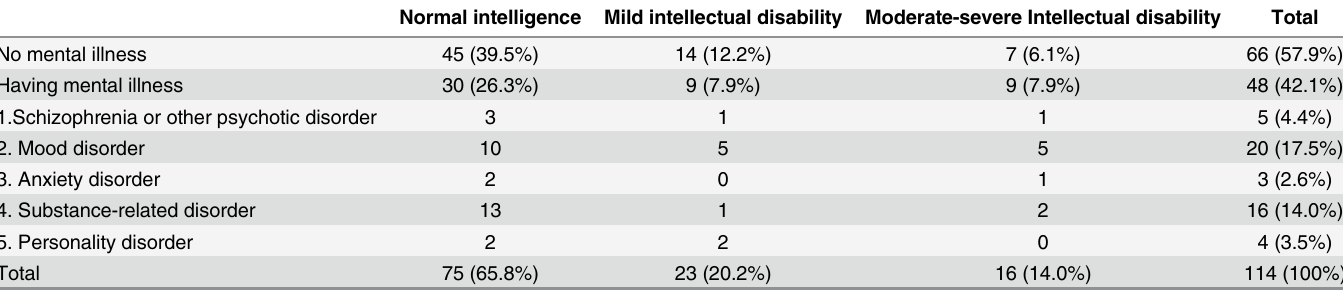
Table 2. Relationships between diagnosed mental illness and cognitive